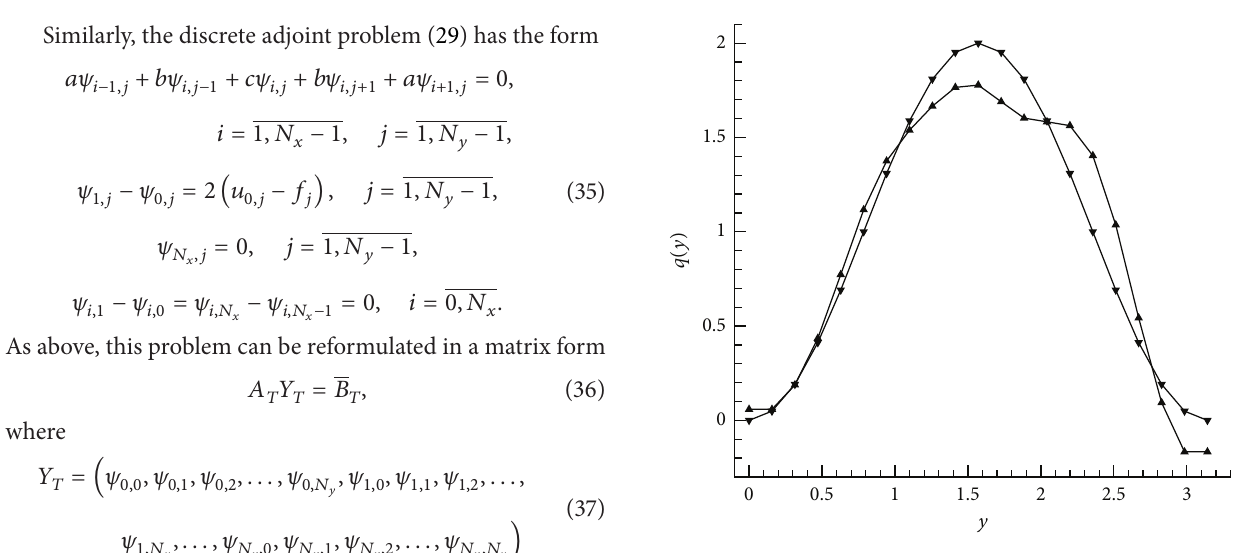
Figure 1: 󳶃 indicates exact solution; 󳵳 indicates solution obtained by the Landweber iteration.